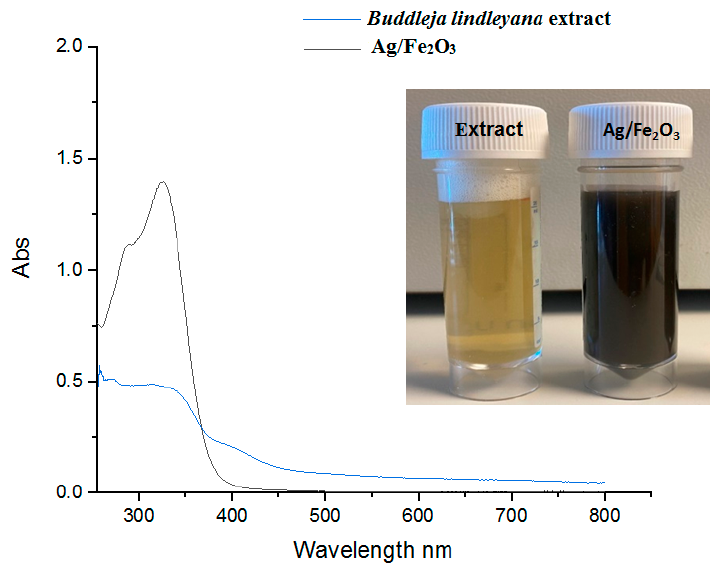
Figure 2. Color change and UV-Vis absorption spectra of Ag/Fe 2 O 3 nanocomposite synthesis by Buddleja lindleyana extract.